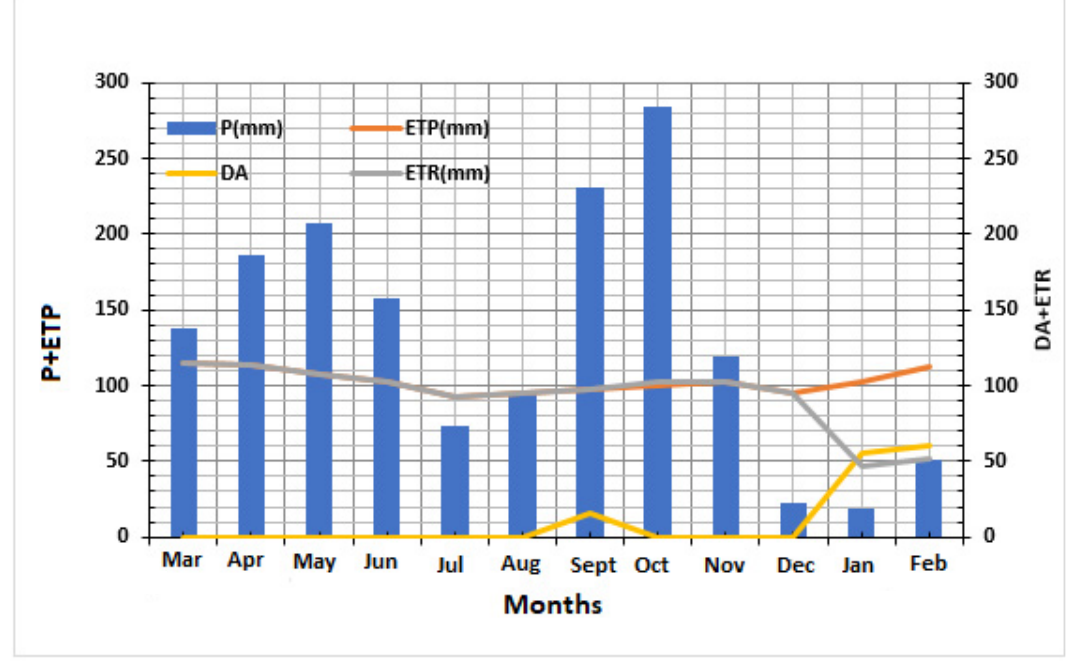
Figure 7. Evolution of some parameters of the hydric balance established according to the Thornthwaite method (uncertainty: ∓1𝑚𝑚) .